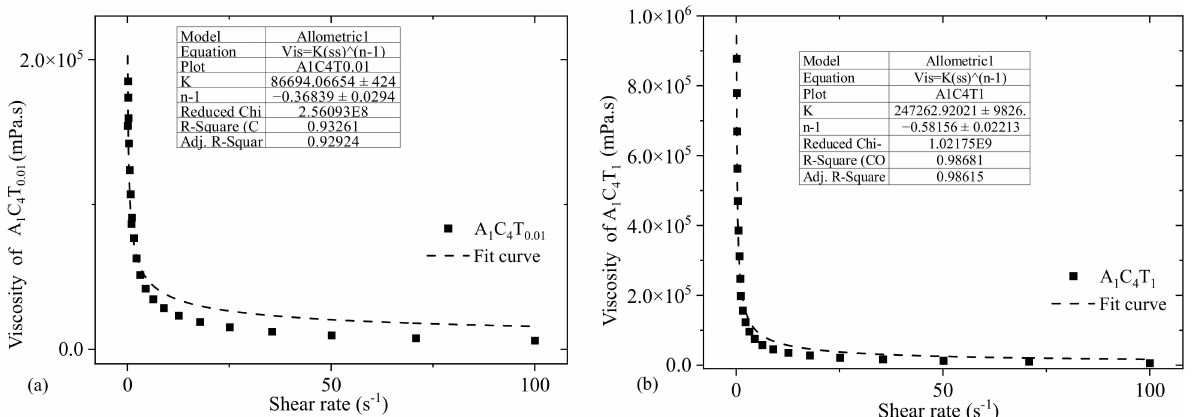
Figure 3. Estimating the values of shear thinning factors ( n and K ) of compositions ( a ) A 1 C 4 T 0.01 and ( b ) A 1 C 4 T 1 . For A 1 C 4 T 0.01 , n and K values were 0.64 and 86694 ± 424 (mPaS) with an R-square value of 0.929, whereas, for A 1 C 4 T 1 , n and K values were 0.42 and 247262 ± 9826 (mPaS) with an R-square value of